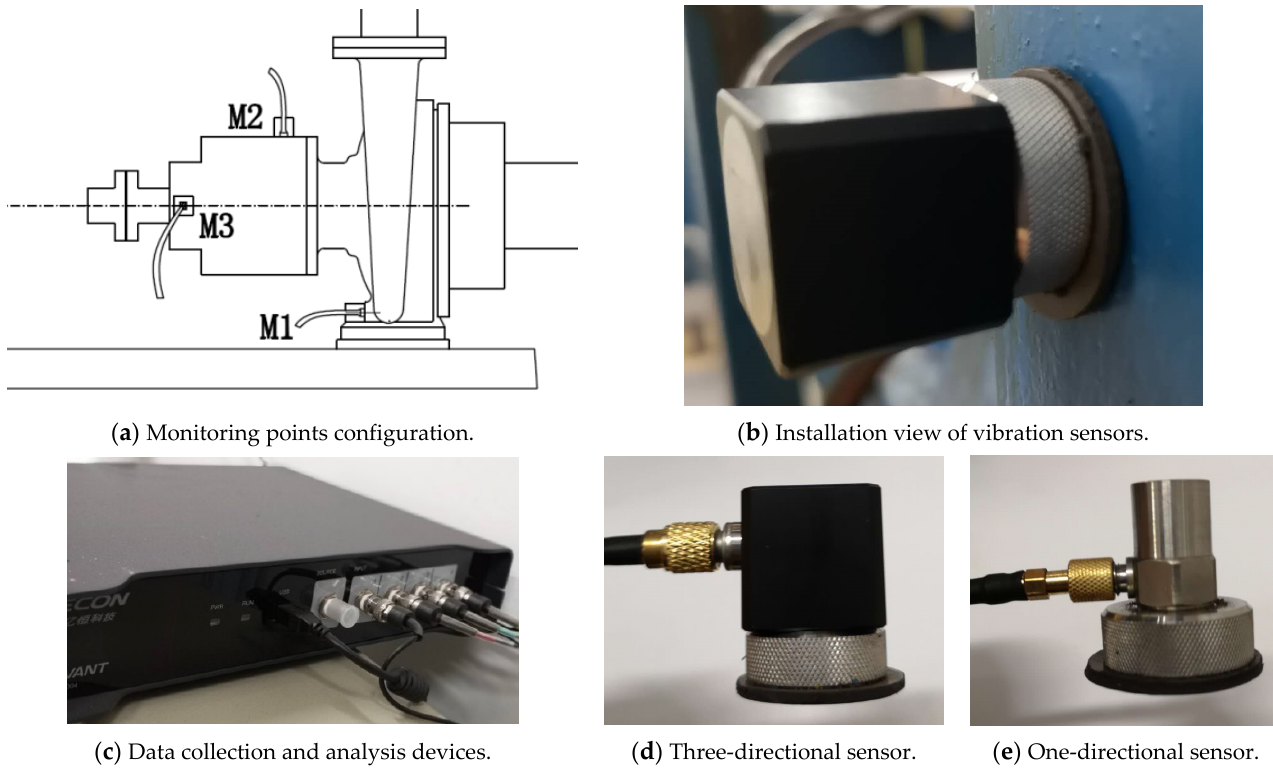
Figure 19. Monitoring locations of vibration test. Table 4. Time-averaged BEPs vibration data.